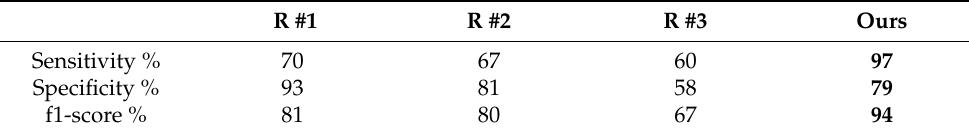
Table 3. Sensitivity, specificity, and f1-score for polyp detection.